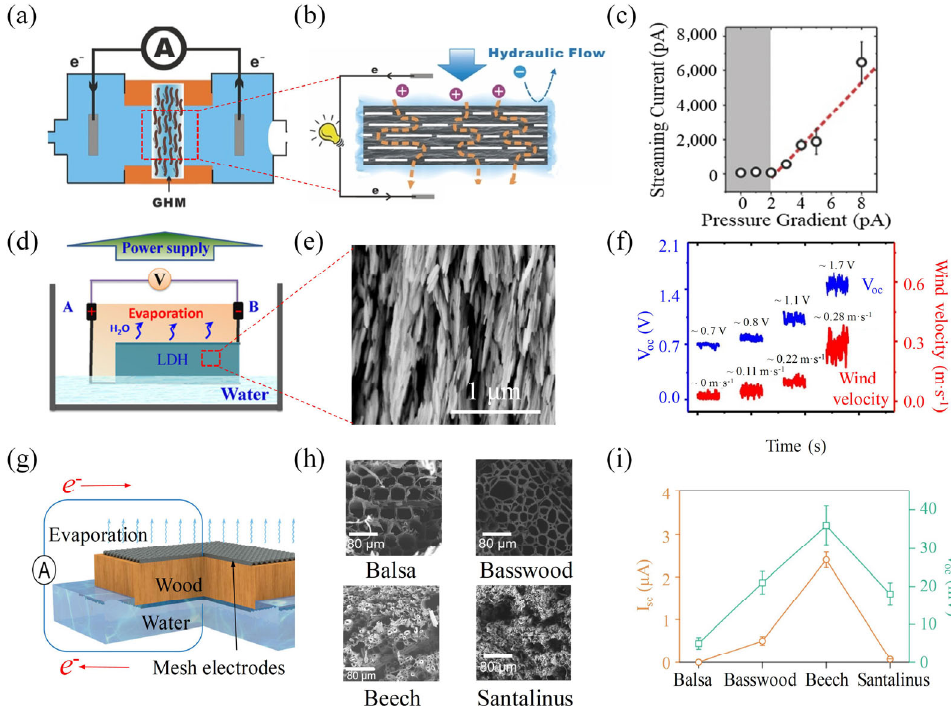
Figure 4 Bio-inspired evaporation-driven electricity generator. (a) Schematic illustration of GHM-based evaporation-driven electricity generator. (b) Working mechanism of the GHM-based evaporation-driven electricity generator. (c) Factors affecting the electrical output of the GHM-based evaporation-driven electricity generator. (a)–(c) Reproduced with permission from Ref. [103], © Wiley-VCH Verlag 2013. (d) Schematic illustration of LDH-based evaporation-driven electricity generator. (e) SEM image of a Ni–Al LDH film, showing natural micro channel. (f) Relationship between the electrical output and wind speed. (d)–(f) Reproduced with permission from Ref. [105], © Elsevier B.V. 2019. (g) Schematic diagram of a wood-based evaporation-driven electricity generator. (h) SEM images of different woods-based evaporation-driven electricity generator (Scale bar: 80 μm). (i) Open circuit voltage and short circuit current of different woods-based evaporation-driven electricity generator. (g)–(i) Reproduced with permission from Ref. [106], © American Chemical Society